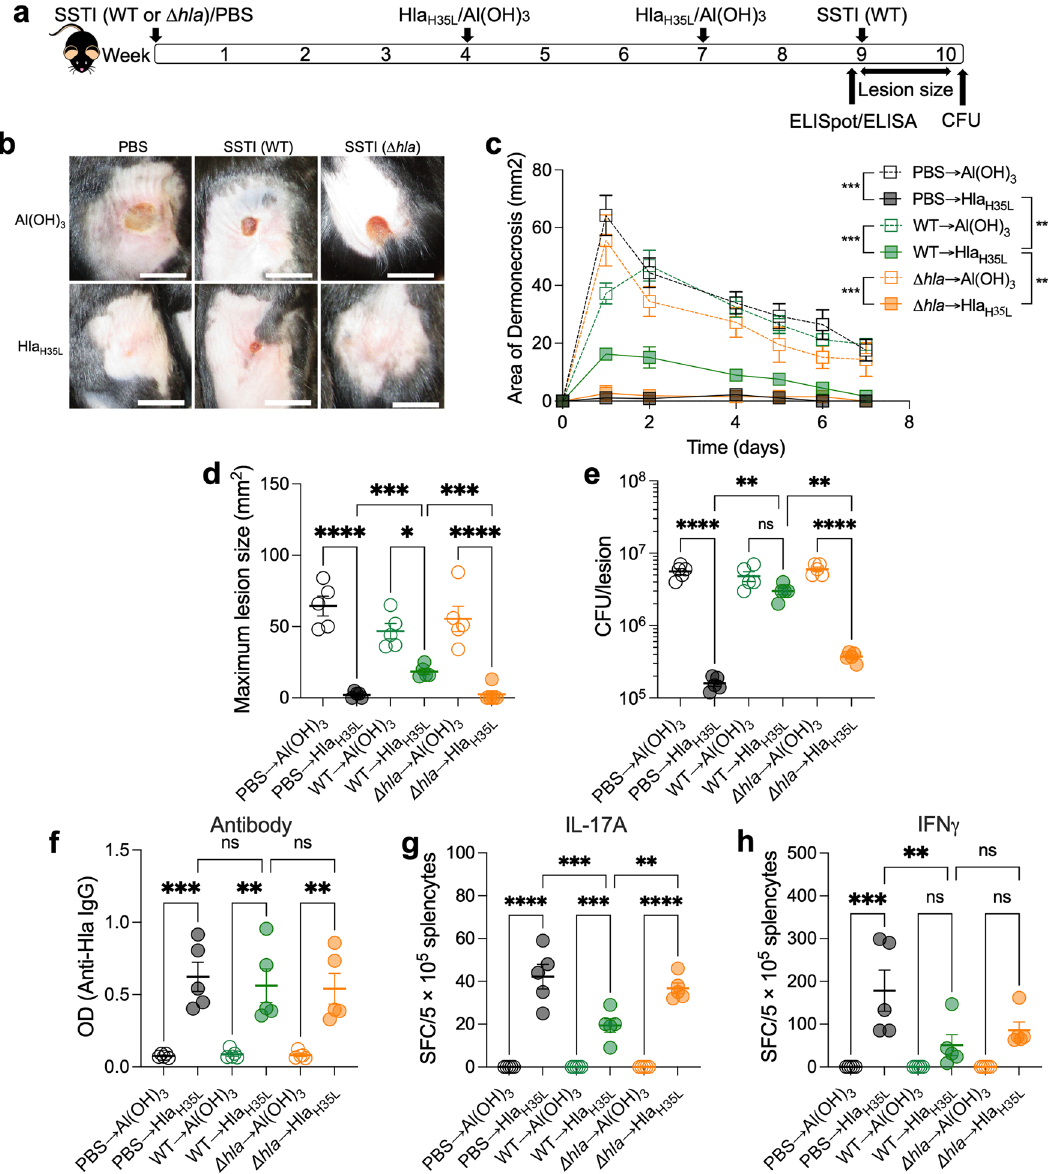
Fig. 4 Hla expression during SSTI is necessary for impairment of vaccine ef fi cacy and vaccine-speci fi c T cell responses. a Experimental model: C57BL/6 mice were infected with wild-type (WT) S. aureus or an isogenic hla deletion mutant ( Δ hla ) SSTI followed by vaccination at a distal site with Hla H35L and secondary SSTI with WT S. aureus or quanti fi cation of anti-Hla IgG levels by ELISA or Hla-speci fi c T cell responses by IL-17A or IFN γ ELISpot on cultured splenocytes. b Representative photos of mouse lesions on day 2. Scale bar = 10 mm. b – d Vaccine-mediated protection against secondary dermonecrosis was rescued in mice that received primary SSTI with Δ hla ( Δ hla → Hla H35L ), compared with mice that received primary SSTI with WT (WT → Hla H35L ). e Vaccination resulted in enhanced bacterial clearance in the Δ hla → Hla H35L group, compared with the WT → Hla H35L group. f Vaccine-elicited antibody levels were similar, regardless of whether mice received primary infection with WT or Δ hla . g Primary SSTI with Δ hla rescued Hla-speci fi c IL-17A responses following vaccination; there were higher numbers of IL-17A staining cells in the Δ hla → Hla H35L group, compared with the WT → Hla H35L group. h Although there was a trend toward higher numbers of IFN γ staining cells in the Δ hla → Hla H35L group, the differences were not signi fi cant. N = 5 mice/group; 1 representative experiment of at least two repeats is presented. Data are presented as mean ± SEM and were analyzed using two-way ANOVA with repeated measures and Tukey ’ s post-test ( c ) or one-way ANOVA with Tukey ’ s post-test ( d – h ). CFU data were log 10 transformed for analysis. * indicates p < 0.05; ** p < 0.01; *** p < 0.001; **** p < 0.0001; NS not signi fi